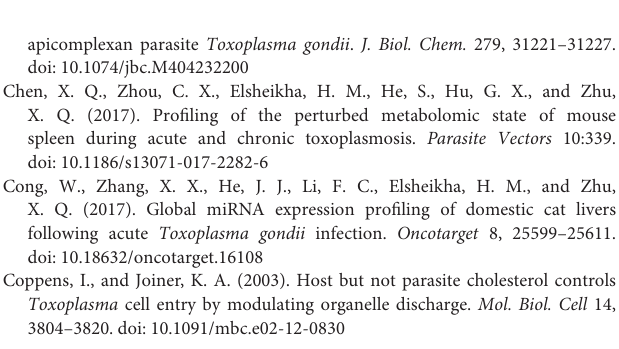
Figure S1 | The original image of Figure 1A . Figure S2 | The original image of Figure 2B . Figure S3 | The original image of Figure 3C . Figure S4 (A) | Total ion current (TIC) chromatograms of liver samples in the positive ion mode (ESI + ). (B) Total ion current (TIC) chromatograms of liver samples in the negative ion mode (ESI–). Figure S5 | Secondary spectrogram information of anandamide. (A) Standard secondary spectrogram of anandamide in the positive ion mode (ESI + ). (B) Secondary spectrogram of experimental samples at similar retention time in the positive ion mode (ESI + ). Figure S6 | Secondary spectrogram information of cholesterol. (A) Standard secondary spectrogram of cholesterol in the positive ion mode (ESI + ). (B) Secondary spectrogram of experimental samples at similar retention time in the positive ion mode (ESI + ). Figure S7 | Secondary spectrogram information of choli acid. (A) Standard secondary spectrogram of choli acid in the positive ion mode (ESI + ). (B) Secondary spectrogram of experimental samples at similar retention time in the positive ion mode (ESI + ). Figure S8 | Secondary spectrogram information of lithocholic acid. (A) Standard secondary spectrogram of lithocholic acid in the positive ion mode (ESI + ). (B) Secondary spectrogram of experimental samples at similar retention time in the positive ion mode (ESI + ). Figure S9 | Secondary spectrogram information of L-Thyroxine. (A) Standard secondary spectrogram of L-Thyroxine in the positive ion mode (ESI + ). (B) Secondary spectrogram of experimental samples at similar retention time in the positive ion mode (ESI + ). Figure S10 | Secondary spectrogram information of oleic acid. (A) Standard secondary spectrogram of oleic acid in the positive ion mode (ESI + ). (B) Secondary spectrogram of experimental samples at similar retention time in the positive ion mode (ESI + ). Figure S11 | Secondary spectrogram information of sphinganine. (A) Standard secondary spectrogram of sphinganine in the positive ion mode (ESI + ). (B) Secondary spectrogram of experimental samples at similar retention time in the positive ion mode (ESI + ). Table S1 | Summary results of the differential ions. Table S2 | List of metabolites identified during acute Toxoplasma gondii infection. Table S3 | List of metabolites identified during chronic Toxoplasma gondii